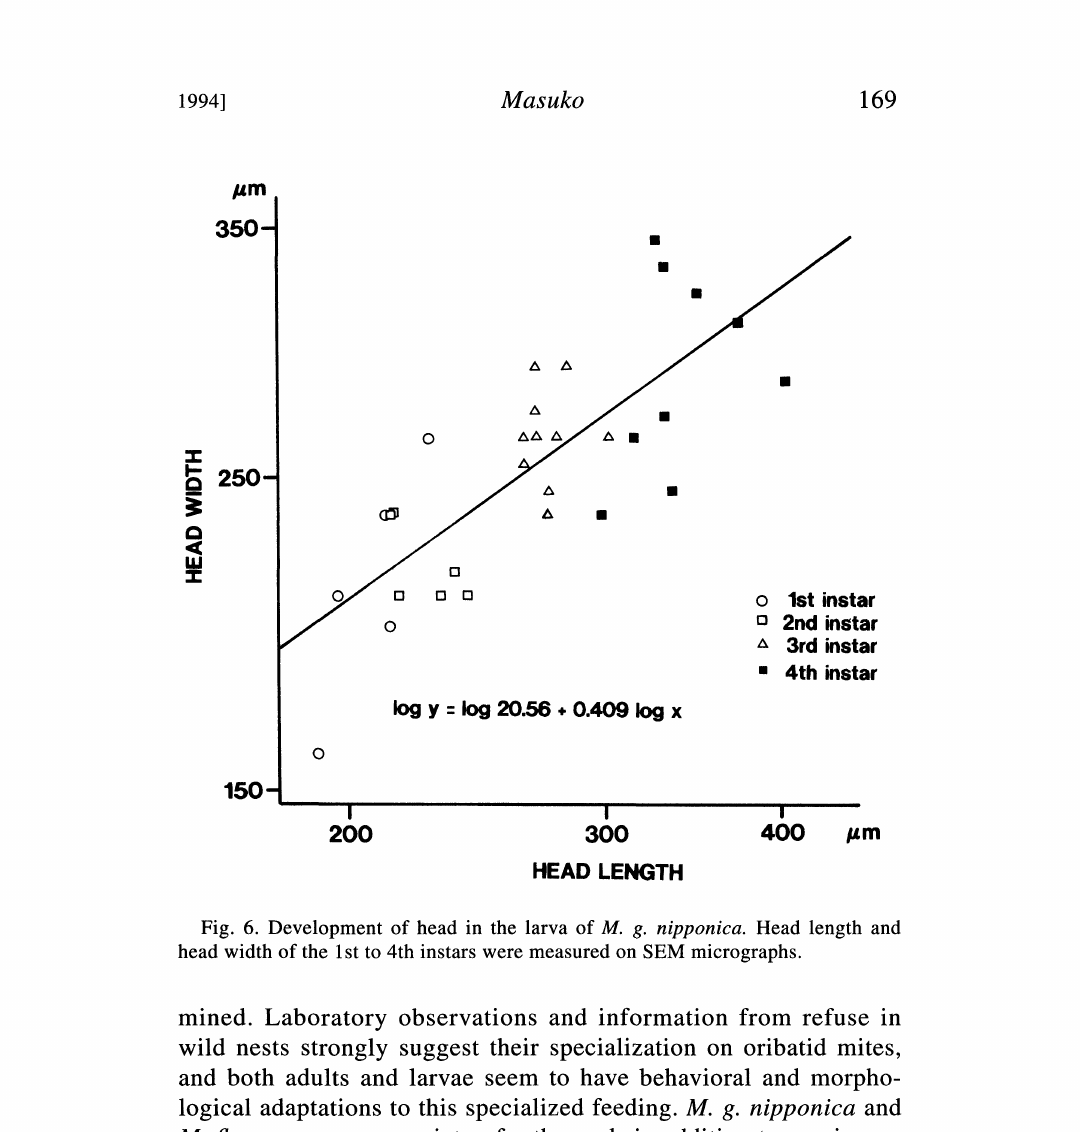
Fig. 6. Development of head in the larva of M. g. nipponica. Head length and head width of the st to 4th instars were measured on SEM micrographs. mined. Laboratory observations and information from refuse in wild nests strongly suggest their specialization on oribatid mites, and both adults and larvae seem to have behavioral and morpho- logical adaptations to this specialized feeding. M. g. nipponica and M. flava scavenge a variety of arthropods in addition to preying on oribatids. Specialization would not necessarily lead to strict nar- rowing of the prey regime. Rather, a combination of specialization on a certain prey group and scavenging on a broad spectrum of organisms might be common in specialist predators, e.g. members of Dacetini (Masuko